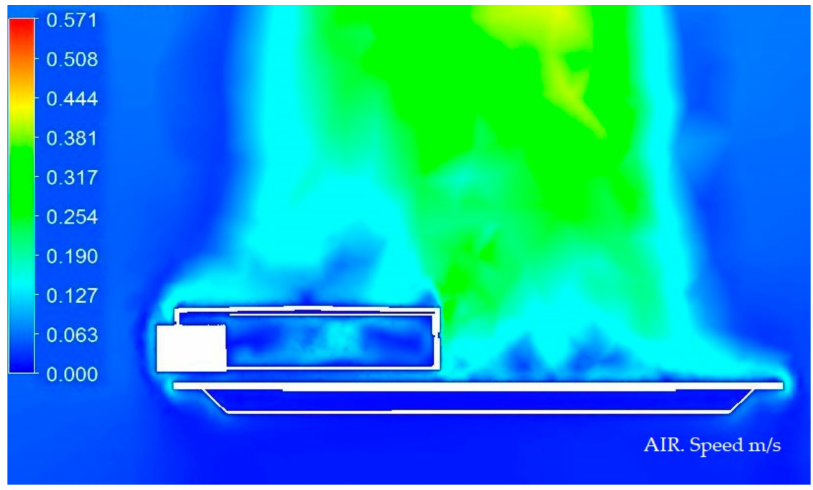
Figure 9. Speed section medium of the luminaire at 20 ◦ C. Source: HyperView software.